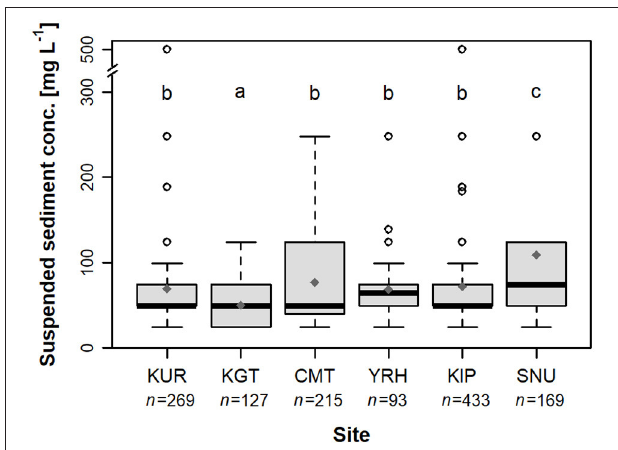
FIGURE 7 | Variation in suspended sediment concentrations across the monitoring sites for the sampling period September 2017 to September 2019. The lower and upper lines of the boxplots correspond to the 1st and 3rd quantile ( Q 1 and Q 3 ), respectively, while the solid horizontal line inside the box represents the median value ( Q 2 ). The lower and upper whiskers show the minimum and maximum values within 1.5 times the interquartile range, while the circle markers represent extreme values outside of that range. Significant differences among sites are indicated with different letters ( P <